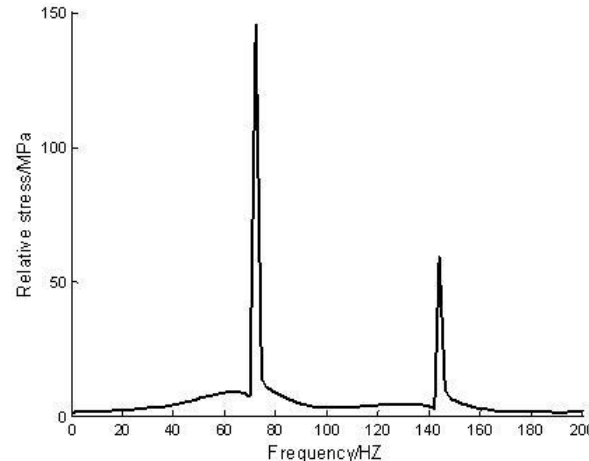
Figure 7. Amplitude-frequency characteristic curve of stress.